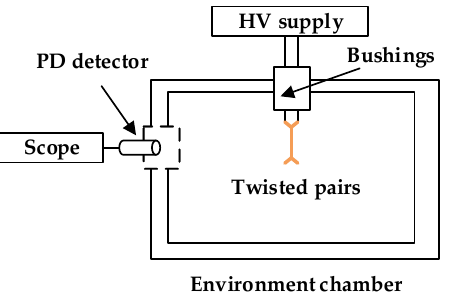
Figure 11. A typical PDIV investigation experiment setup.